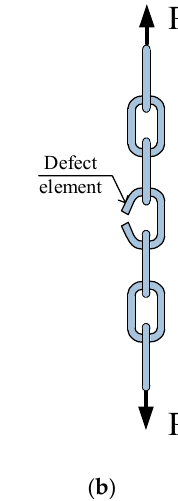
Figure 10. Models for explaining statistical approaches. ( a ) Brick stack under compression. ( b ) Chain under tension.